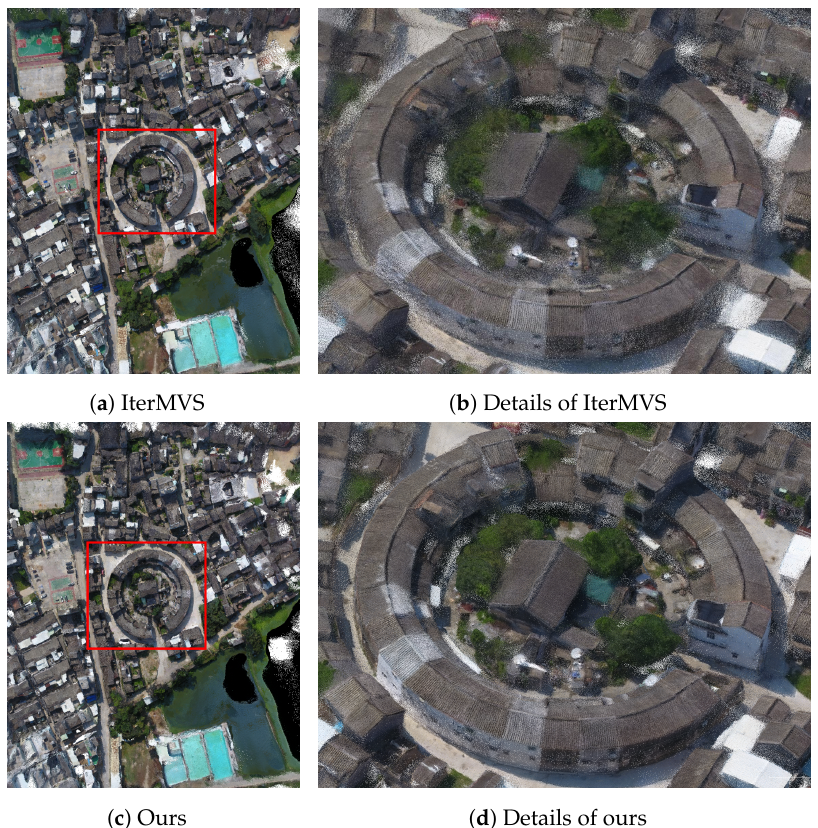
Figure 1. Comparison of point clouds on the BlendedMVS validation set. The scene is generated from aerial images captured by drones, and the IterMVS [24] point cloud is unrefined in terms of details such as eaves, while our point cloud is more